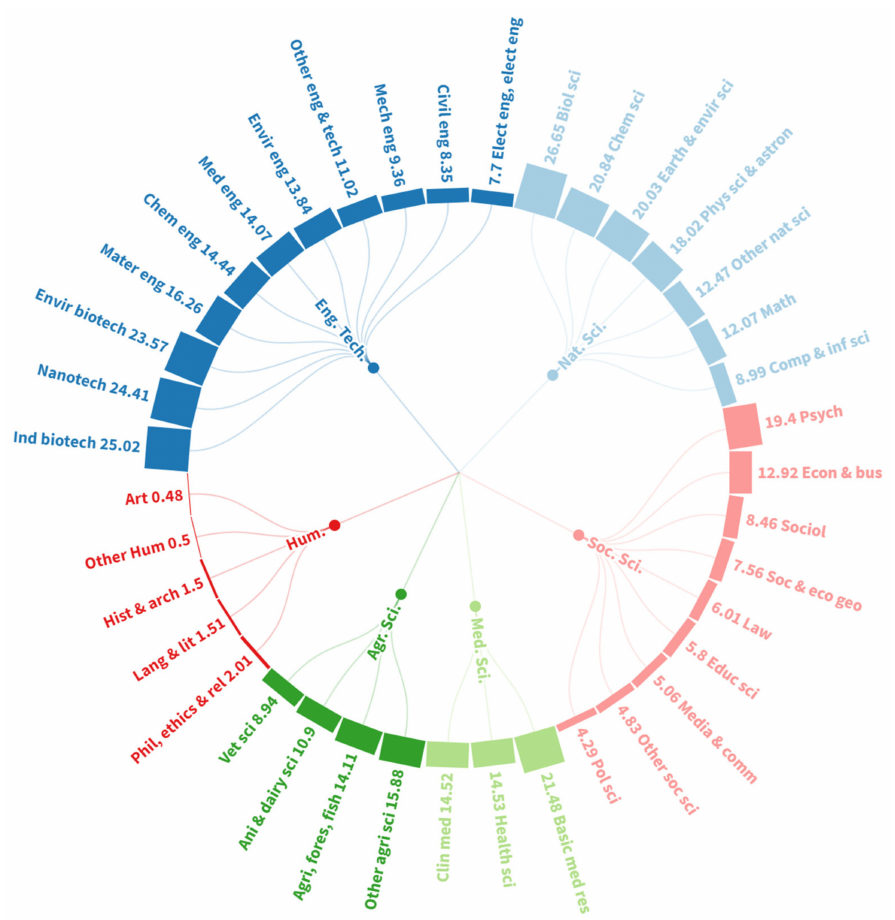
Figure A2. Citations per paper for 6 main and 39 s-level OECD